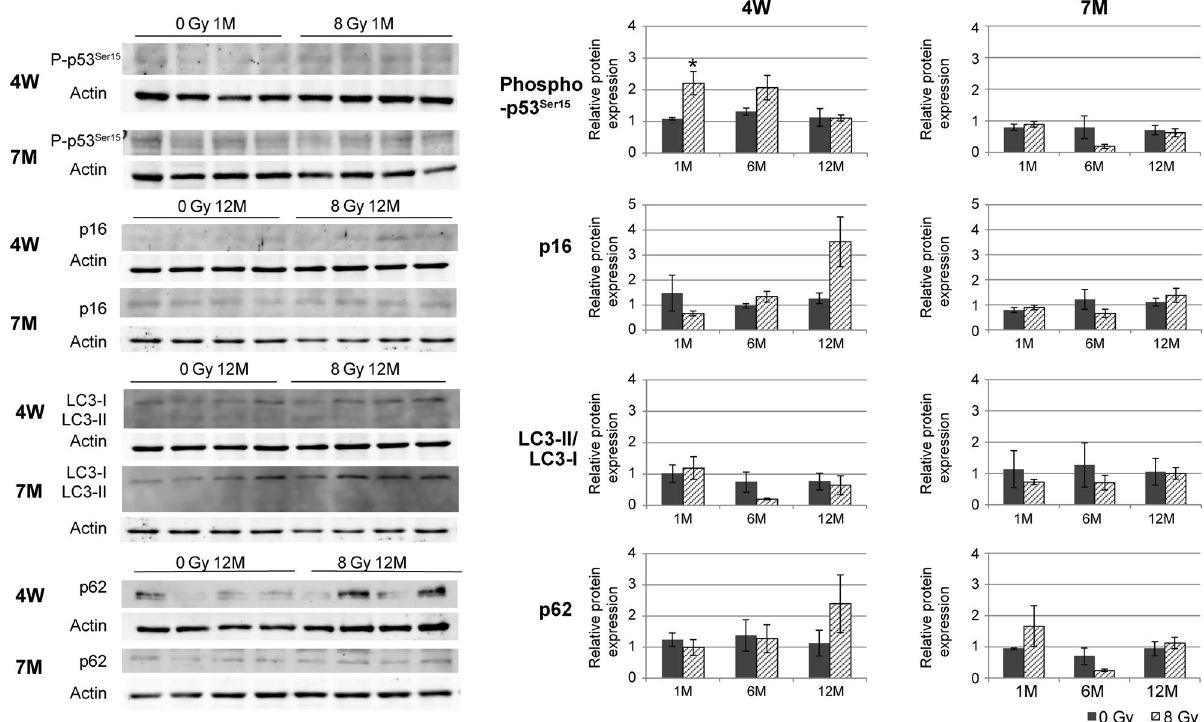
Figure 3. Levels of phospho-p53 Ser15 , p16, LC3-II/LC3-I, and p62 in the thyroid tissue of nonirradiated (control) and irradiated 4W and 7M rats, determined via western blotting at 1, 6, and 12 months after irradiation. Data are expressed as mean ± SEM of four to six rats per data point. * p < 0.05 vs. nonirradiated